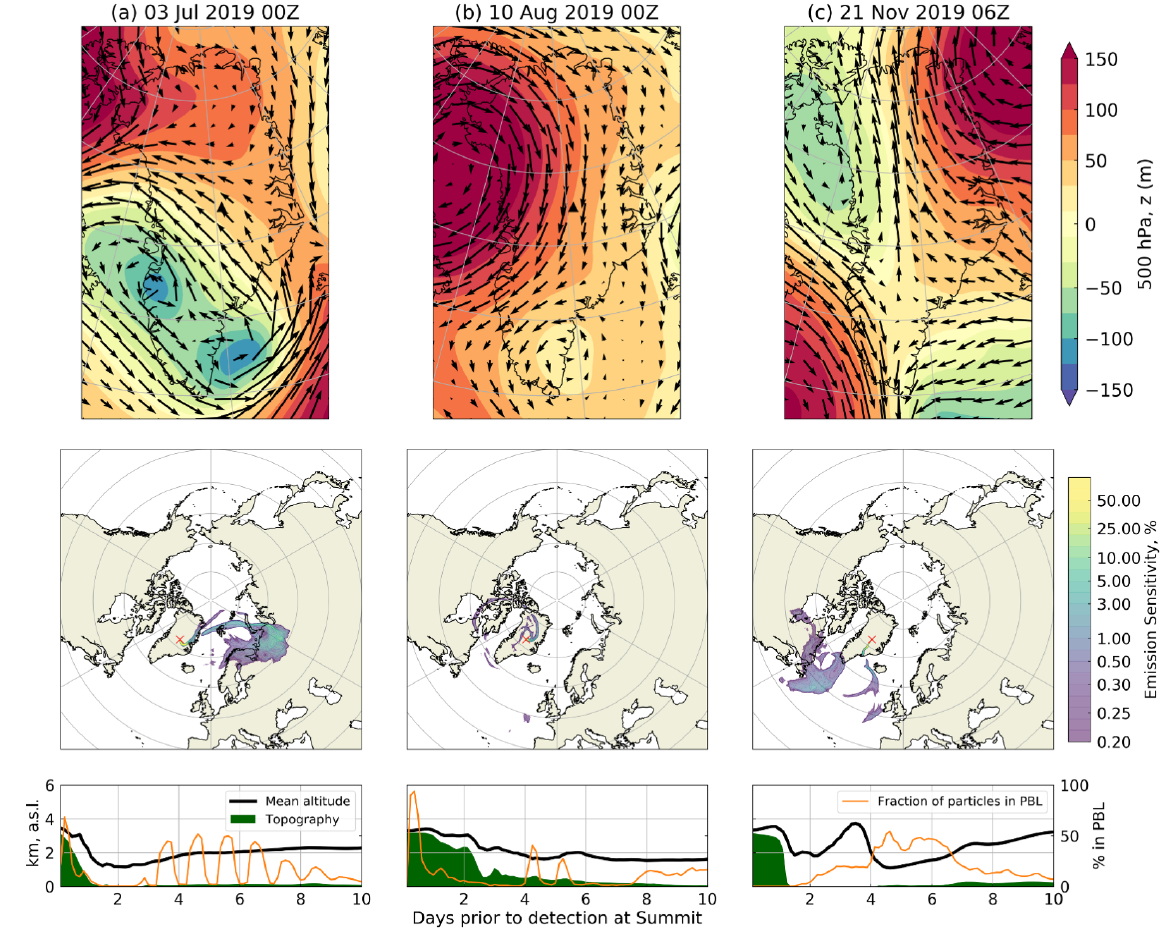
Figure 10. Synoptic anomaly plots and aerosol transport pathways during the three low- N 20 cases studies. Upper row: 500hPa geopotential height and horizontal wind anomalies from ERA5. Middle row: FLEXPART surface emission sensitivity (as a percentage of the maximum value) over the 10d prior to aerosol detection at Summit. Lower row: FLEXPART mean aerosol transport height (back bold line) and percentage of particles within the planetary boundary layer (orange line) over the 10d prior to detection at Summit. The shaded green area represents the mean height of topography beneath all